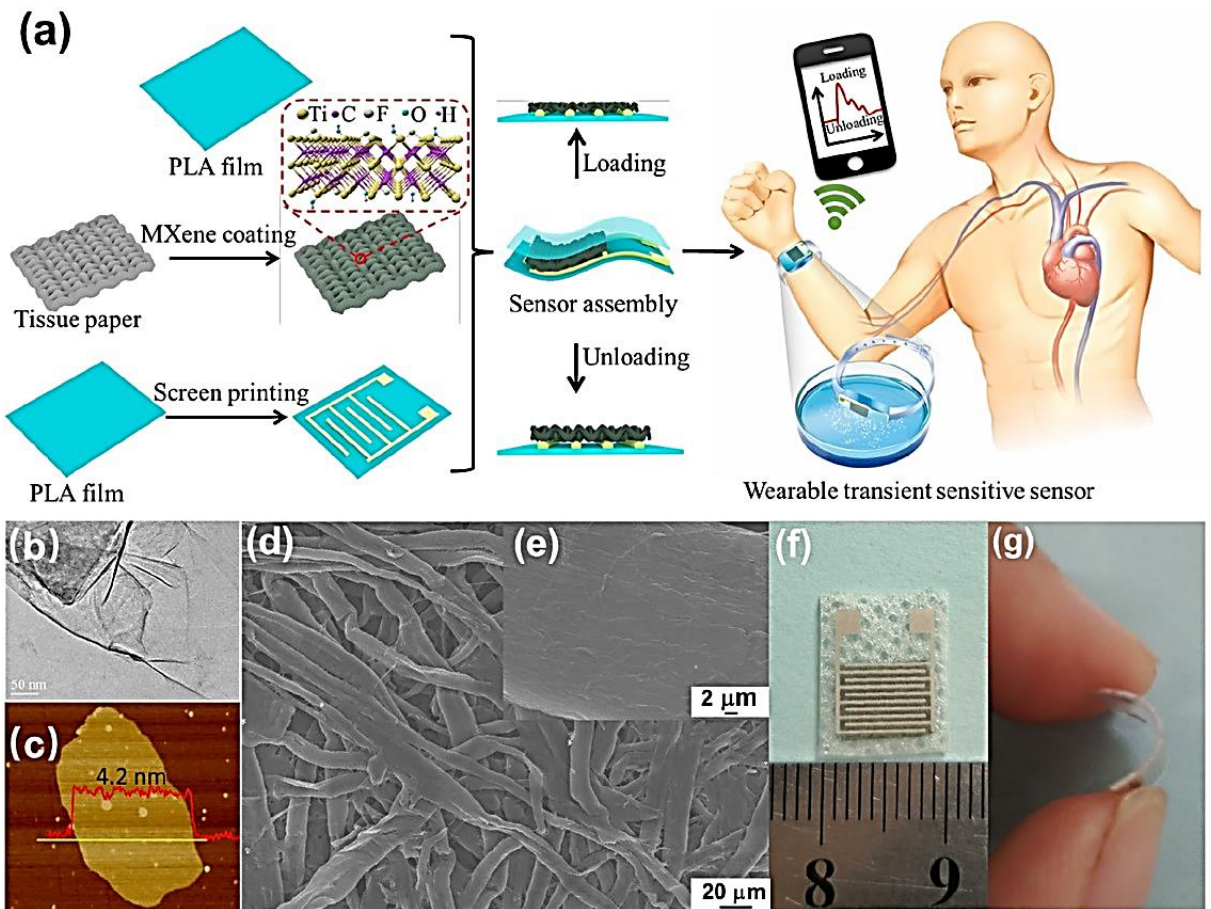
Figure 12. MXene nanosheets-based composites for wearable pressure human sensors (Reprinted with permission from Reference [157] Copyright 2017 American Chemical Society). ( a ) Fabrication of flexible wearable transient pressure sensor using MXene sheets. The ( b – e ) represent TEM image of MXene nanosheets, AFM image of MXene nanosheets deposited on mica plate, SEM image of MXene/tissue paper, SEM image of MXene/tissue paper fiber, respectively. The ( f , g ) are the photographs of the pressure sensor.